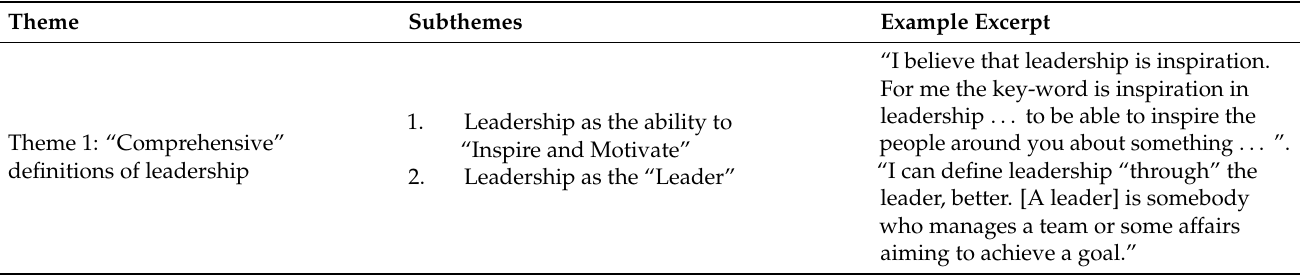
Table 3. Themes and sub-themes that emerged from the